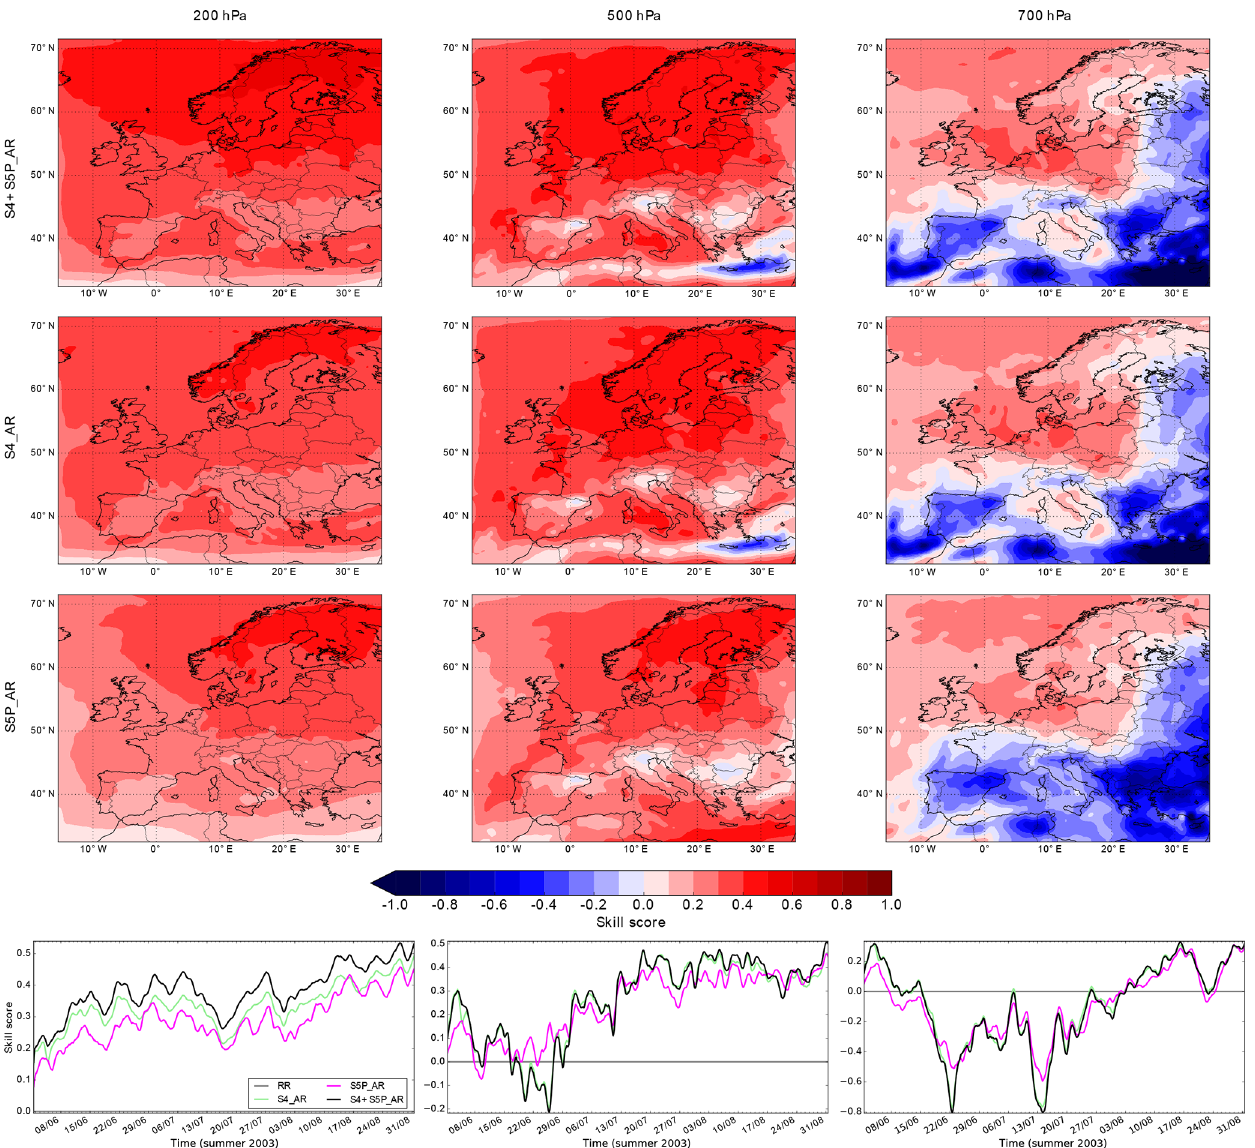
Figure 11. As Fig. 10 but for the skill score maps and time series. Note that there is no skill score map for the reference run because the skill score is calculated with respect to the reference run, so it is equal to 0. The red (blue) end of the colour scale is associated with positive (negative) skill score